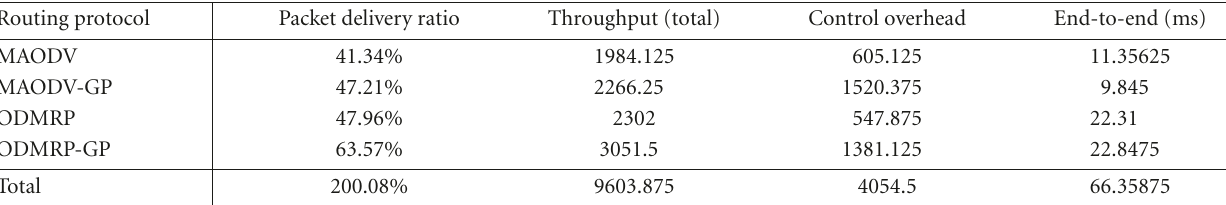
Table 3: Average performances for multicast (40